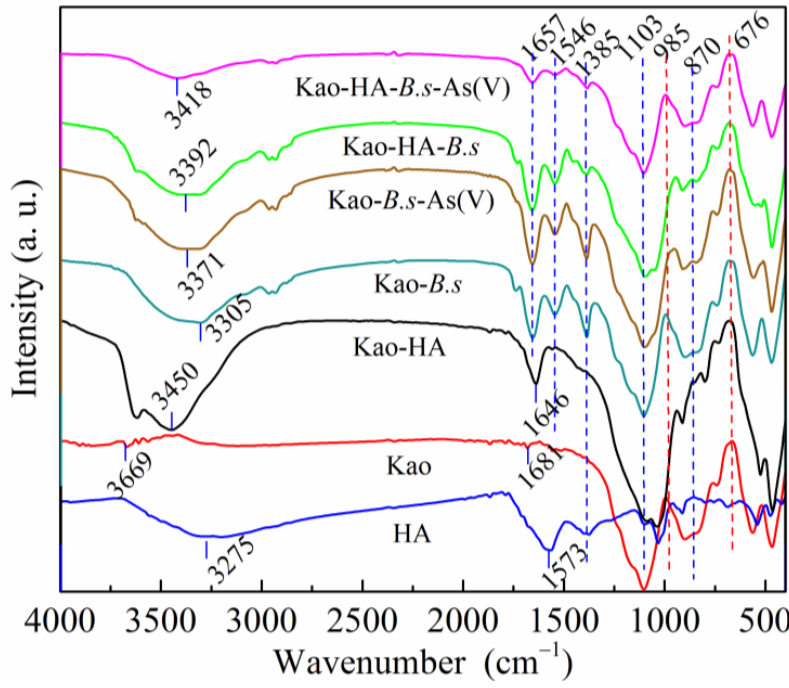
Figure 10. FT-IR spectra of composites before and after reaction with As(V). When compared to the FT-IR spectrum of kaolinite and humic acid, new adsorption peaks appeared after the adsorption of As(V) on the mineral-organic composites. The characteristic of the O-H stretching vibration of water in the complexes and the hydroxyl groups of the physically adsorbed water molecules contributed to the absorption band of kaolinite at ca. 3669 and 1681 cm − 1 before As(V) adsorption [57]; conversely, a bathochromic shift for the O-H band (3418–3305 cm − 1 ) was observed in all the spectra of the Kao- B.subtilis and Kao-HA- B.subtilis composites after As(V)adsorption, which was characteristically enhanced after the bacteria and As(V) were adsorbed on the surface of the kaolinite due to the presence of SiO − and AlO − , which provide relatively strong interactions through inner- spherical surface interactions [39]. However, the intensity of this peak decreased in the ternary system for the inhibitory effect of HA, which was due to the partial coverage of the inner-sphere binding sites of kaolinite, which was also reported by Du and Wu [24,50,52]. Similar trends were observed in the vibrational bands corresponding to the phenolics (1385 cm − 1 ) and aromatics (1573 cm − 1 ) of pure HA spectra and for the C=O and N-H/N-C of amide (1657 and 1546 cm − 1 ) for B.subtilis . When compared to the binary complex of Kao-HA, the new spectra of the Kao-HA- B.subtilis system displayed band shifts for the O-H band (from 3450 to 3392 cm − 1 ) and C=O (from 1646 to 1657 cm − 1 ), and presented the N-H/N-C of amide (1546 cm − 1 ), indicating that the chemical interactions increased during bacteria adhesion to the Kao-HA